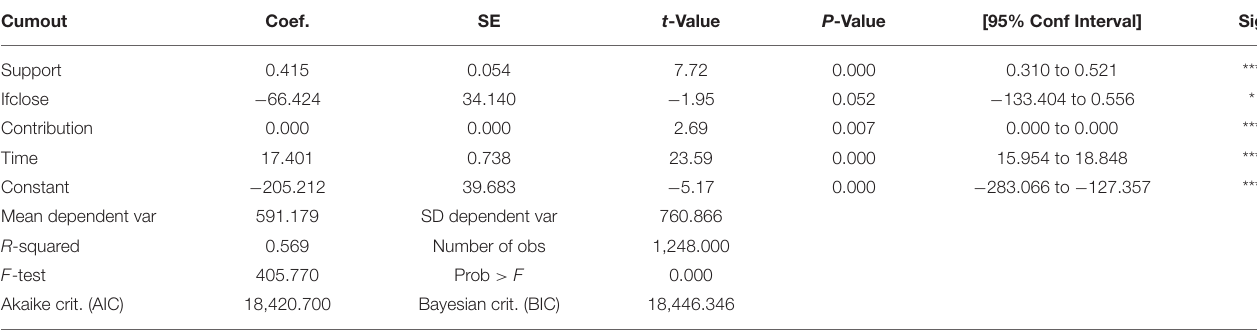
TABLE 5 | The regression results for the two-way fixed effects model of the influence of aid intensity on the cumulative number of discharged patients. Cumout Coef.